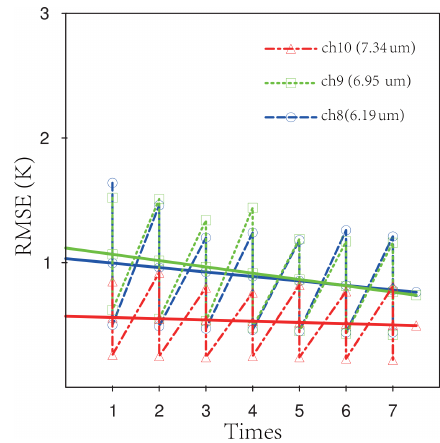
Figure 10. Time series of the RMSE for the brightness temperature (unit: K) with assimilation times before and after the data assimila- tion along with the trend